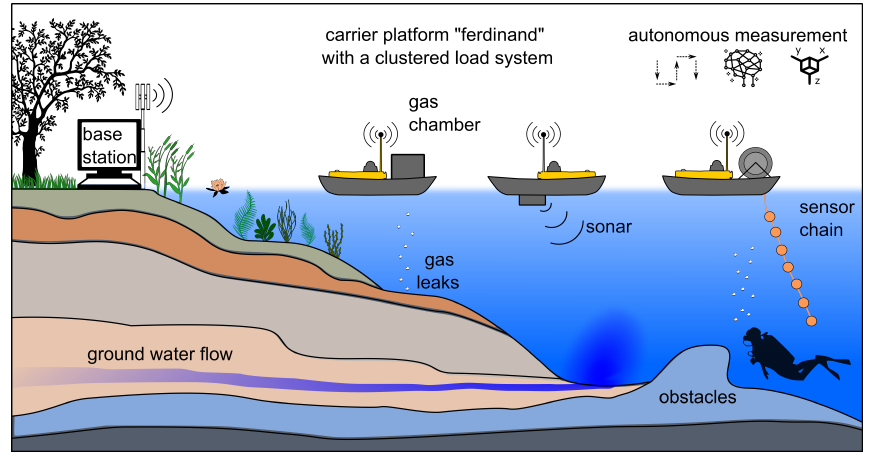
Figure 1. Schematic description of the investigations with the autonomous operation ASV with a continuous, three-dimensional, multisensory recording of inland water bathymetry, depth-resolved water parameters, the detection of groundwater inflow, measurement of water body respiration, validation of the results by scientific divers, and presentation of the results using AI and VR methods.